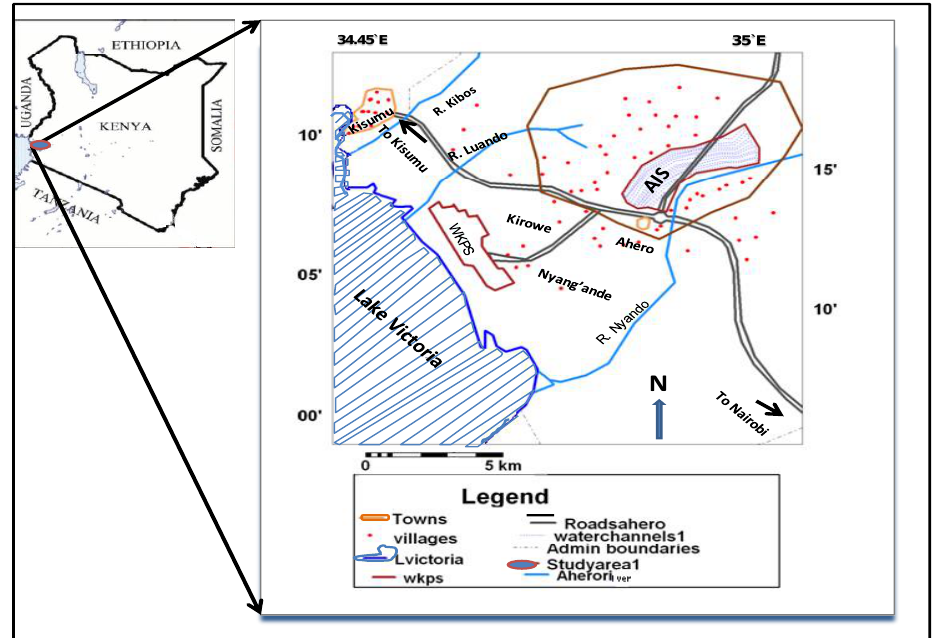
Figure 1. Location Map of Ahero Irrigation Scheme,